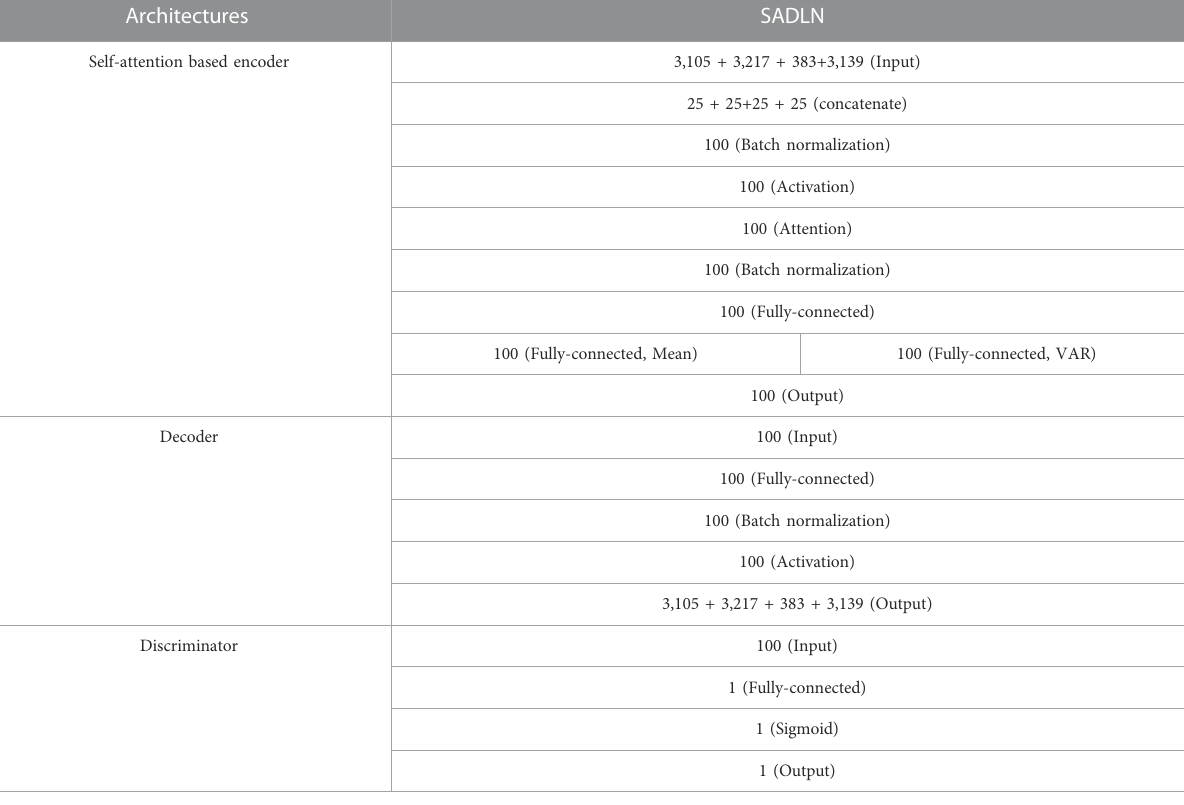
TABLE 1 The network structure of SADLN.